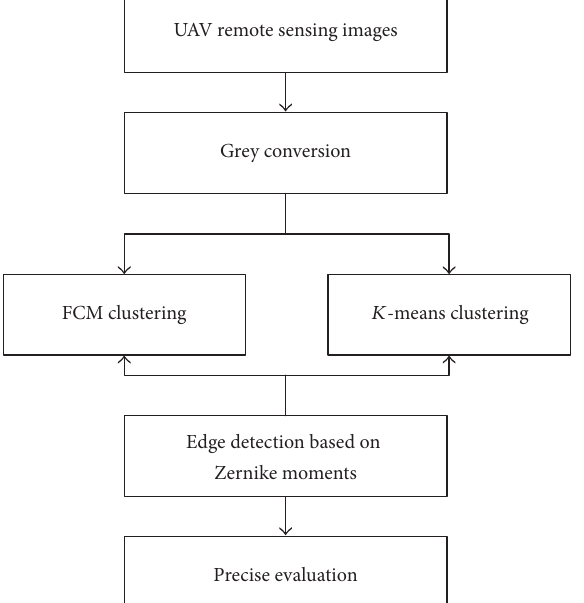
Figure 1: Flowchart of proposed method.